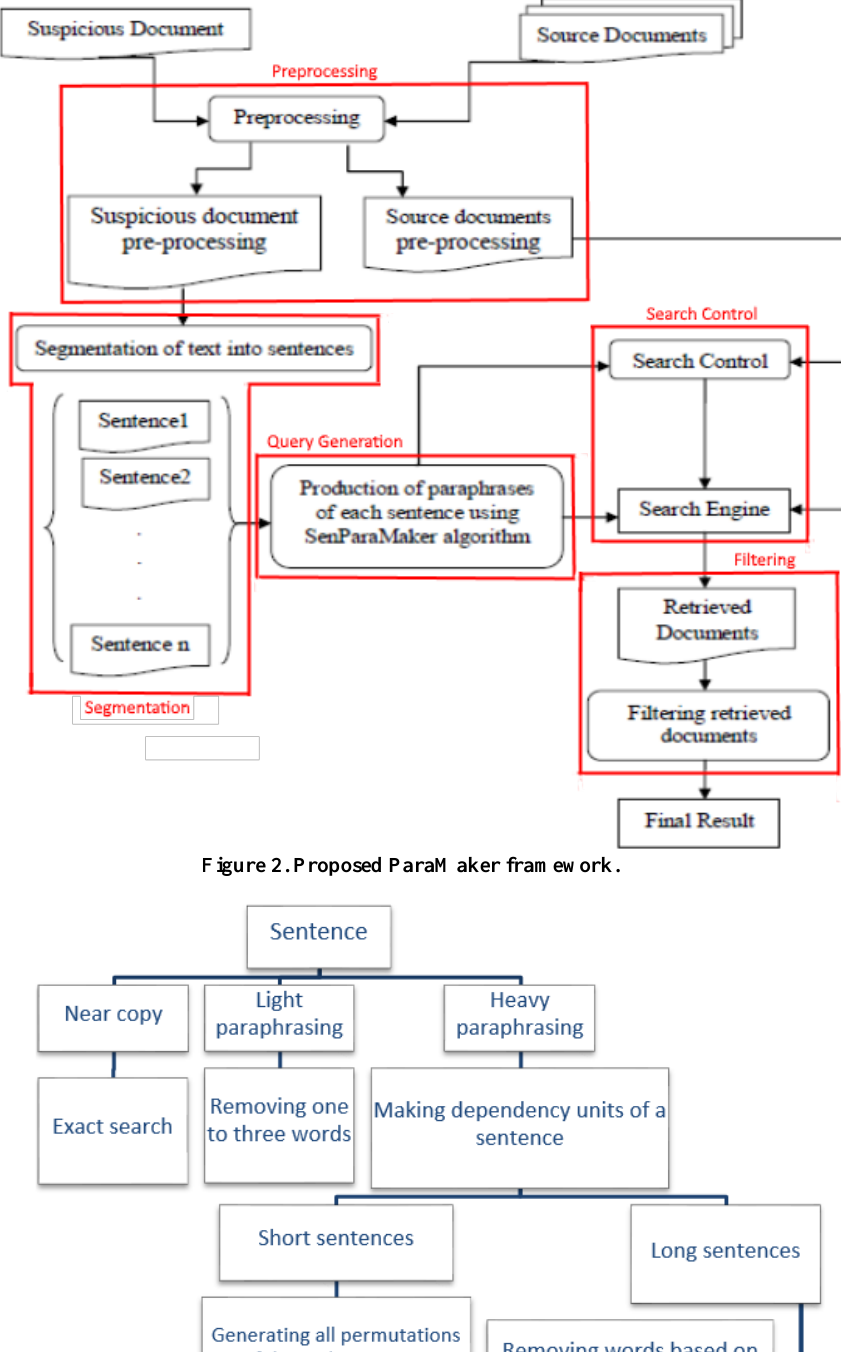
Figure 3. Various Paraphrases of sentences in